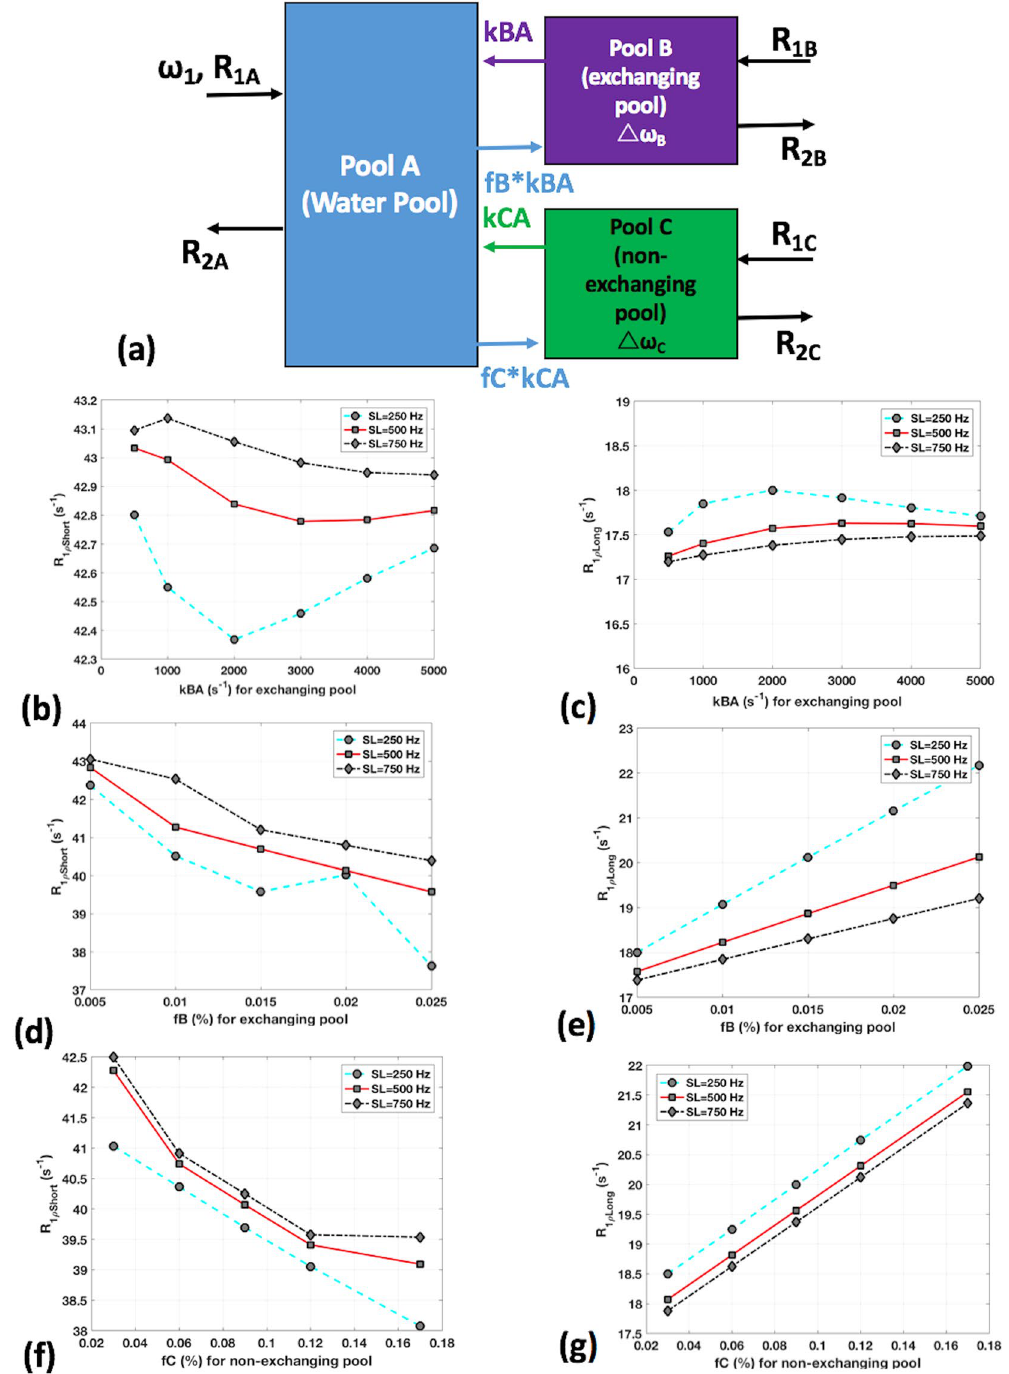
Figure 5. ( a ) shows the Bloch-McConnell simulation with a 3 pool model (water pool, exchanging pool, non- exchanging pool). R1 ρ s ( b ) and R1 ρ l ( c ) variation at different spin-lock powers with exchange rate variation in the exchanging pool, k BA , R1 ρ s ( d ) and R1 ρ l ( e ) with solute concentration variation in the exchanging pool, f B and, R1 ρ s ( f ) and R1 ρ l ( g ) with solute concentration variation in the non-exchanging pool, f